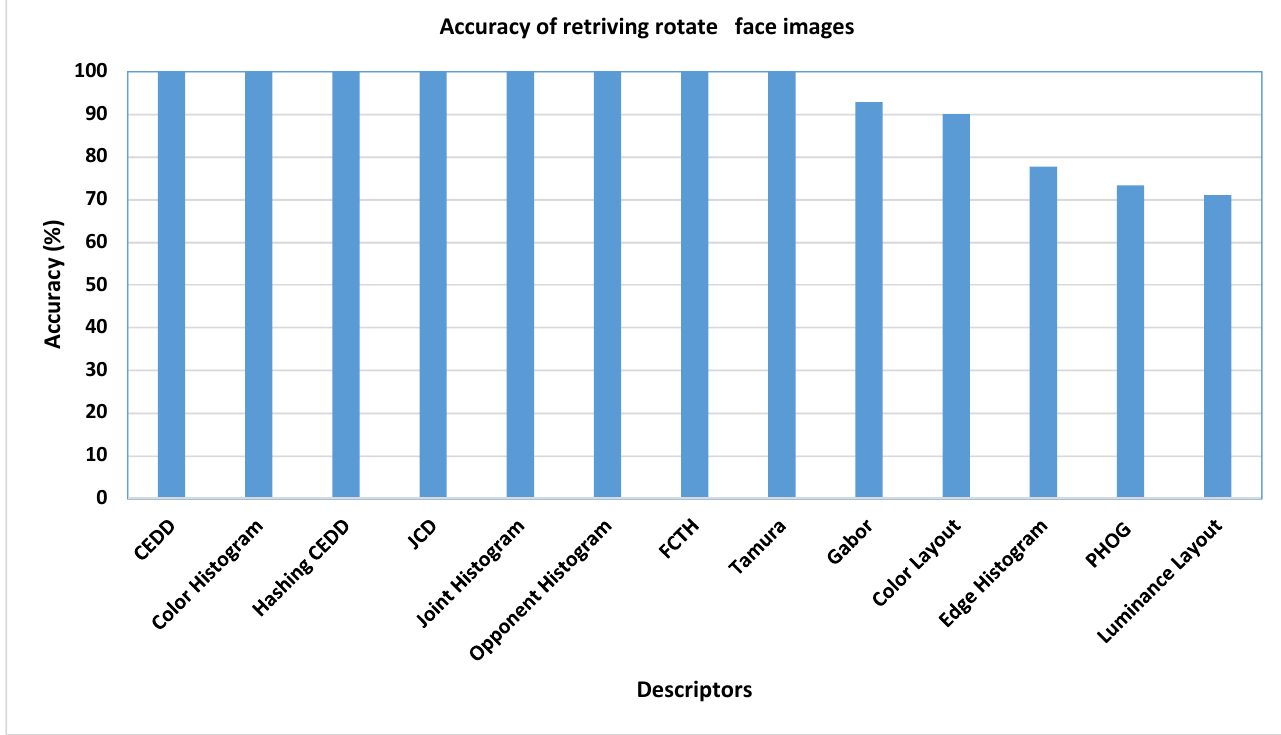
Figure 9. Average accuracy of retrieving rotated face images.